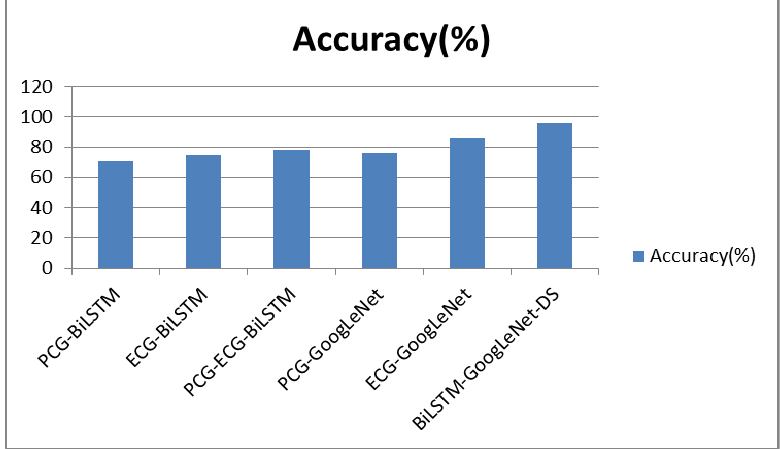
Figure 13. The comparison of accuracy.